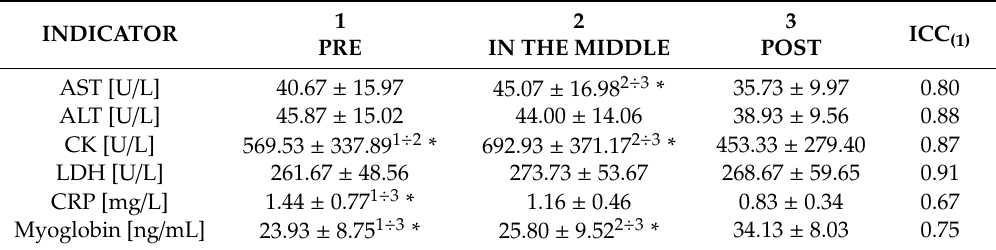
Table 3. Changes in blood biochemical indicators in the three phases of a 12-day sports camp in professional soccer